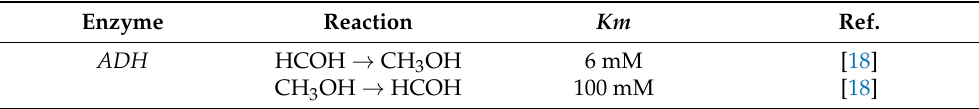
Table 3. Km values for the formaldehyde reduction–methanol oxidation reactions. Enzyme Reaction Km Ref.